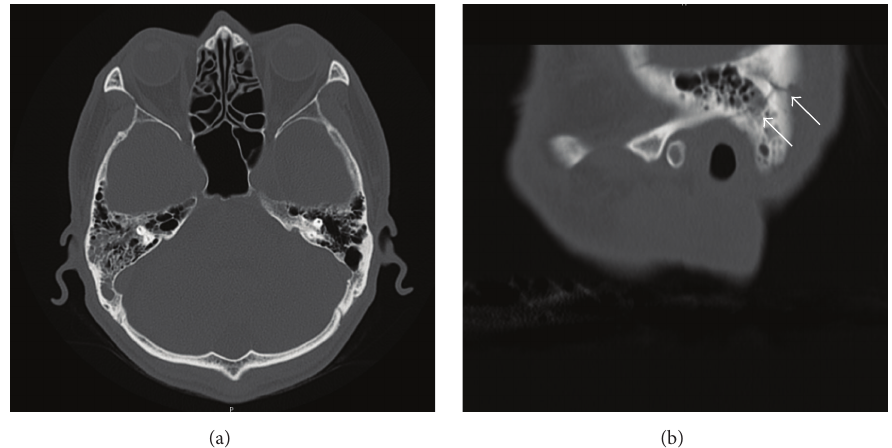
Figure 2: CT scan of the head without contrast 12 days after trauma: (a) axial cut (bone window) cannot show obvious fractures; (b) sagittal cut of the reconstructed CT demonstrates a fracture line in the right temporal bone